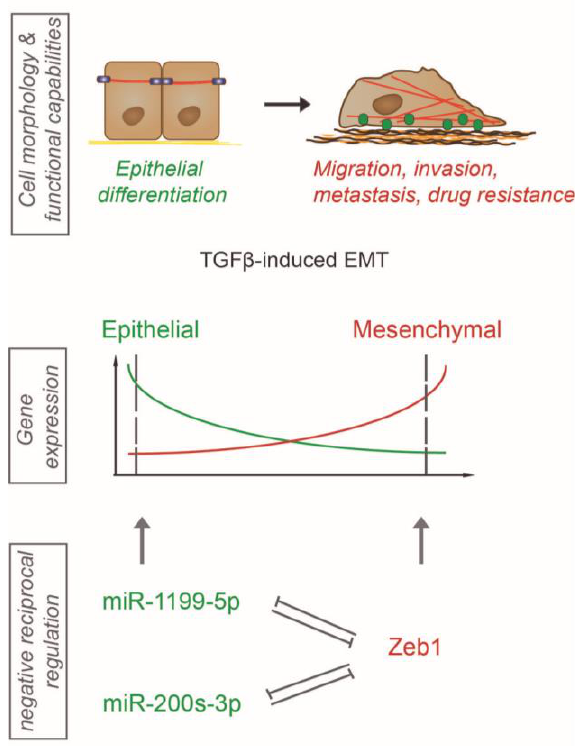
FIGURE 1: MiR-1199-5p and Zeb1 regulation and function during TGFβ-induced EMT. Schematic representation of the results reported by Diepenbruck et al. on the mechanistic function of miR-1199-5p during TGFβ-induced EMT in normal mammary cells and in breast cancer cells. Upon EMT induction, the transcript levels of miR-1199-5p (green) decrease while Zeb1 (red ) tran- scription increases. MiR-1199-5p as well as members of the miR- 200 family and Zeb1 control each other on the transcriptional as well as on the post-transcriptional level in a negative reciprocal regulation. Forced expression of miR-1199-5p prevents TGFβ- induced EMT, mesenchymal tumor cell migration, invasion and metastasis